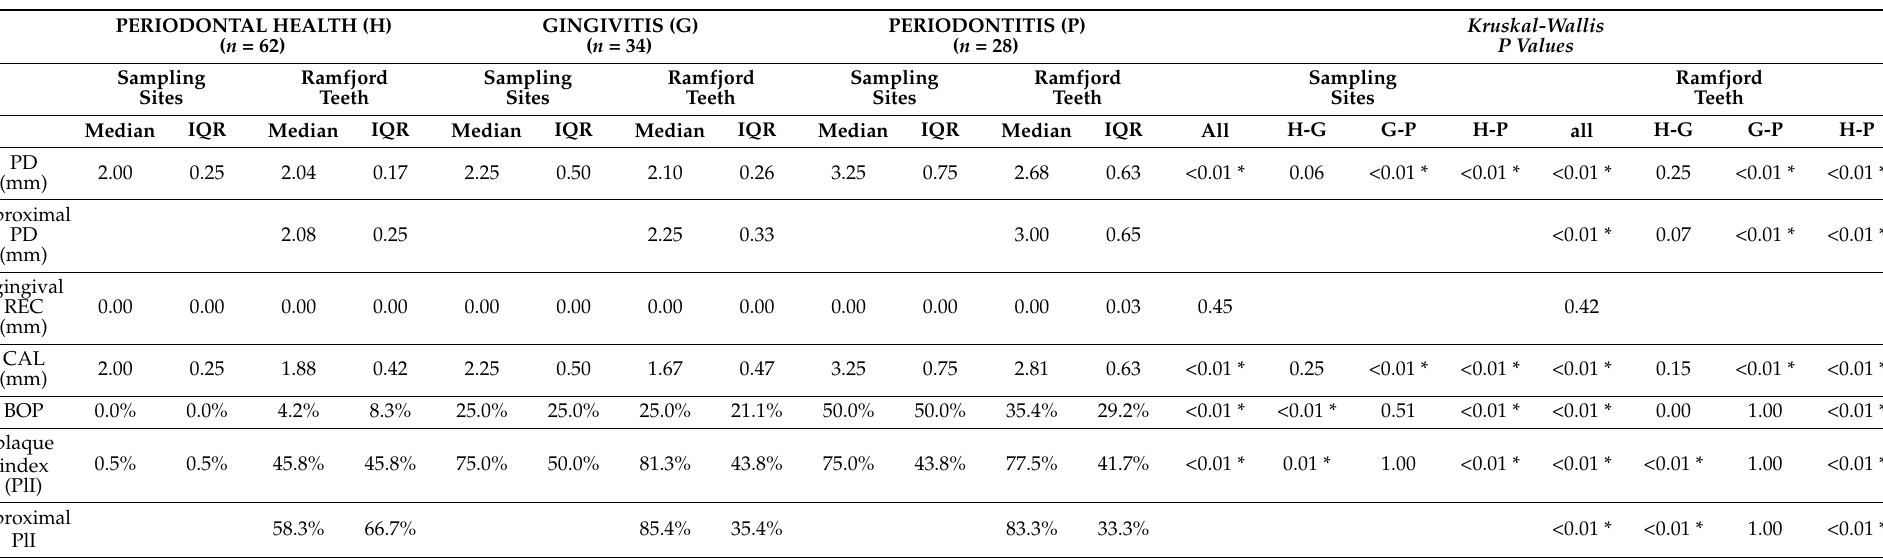
Table 2. Periodontal clinical outcomes, expressed as medians and interquartile ranks (IQR), for each study group, with the appropriate comparisons. PERIODONTAL HEALTH (H) ( n =